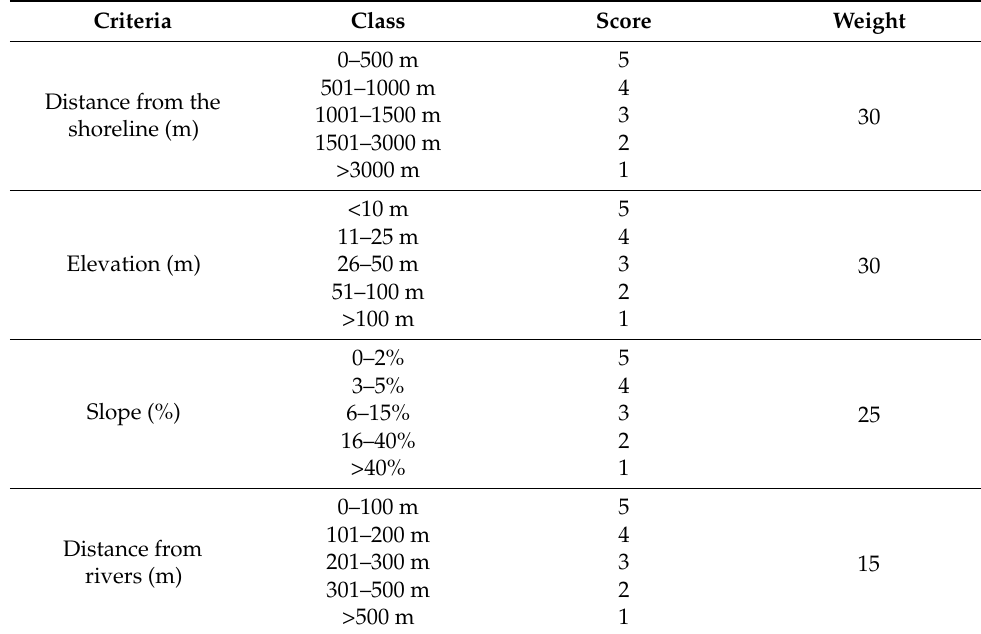
Figure 10. Casualty locations are highlighted in red circles based on the result of scenario 6, the worst-case scenario in terms of the number of casualties. Table 4. Scores and weights for tsunami disaster hazard